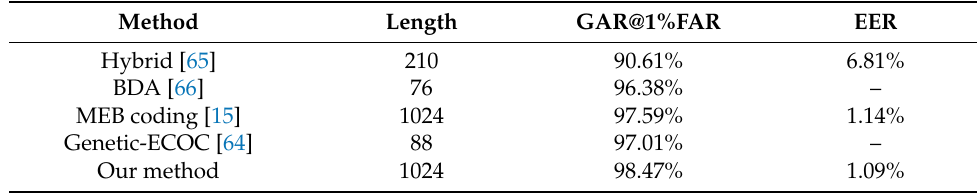
Table 3. Accuracy comparison on CMU-PIE